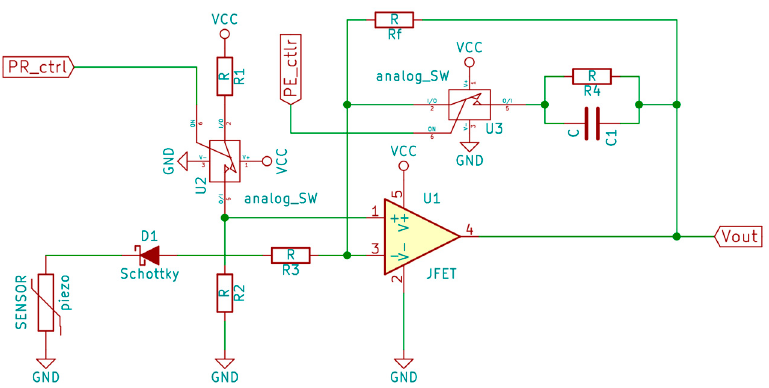
Figure 3. Digitally controlled analog amplification stage. Piezo-Resistive readout, non-inverting configuration, signal PR_ctrl is HIGH (PE_ctrl LOW) to provide an offset at the positive input of the operational amplifier (U1, a JFET). Piezo-electric readout, charge amplifier configuration, the low PR_ctrl signal, drives the V+ JFET input to GND while the PE_ctrl HIGH enables the capacitive feedback (C1 and R4).